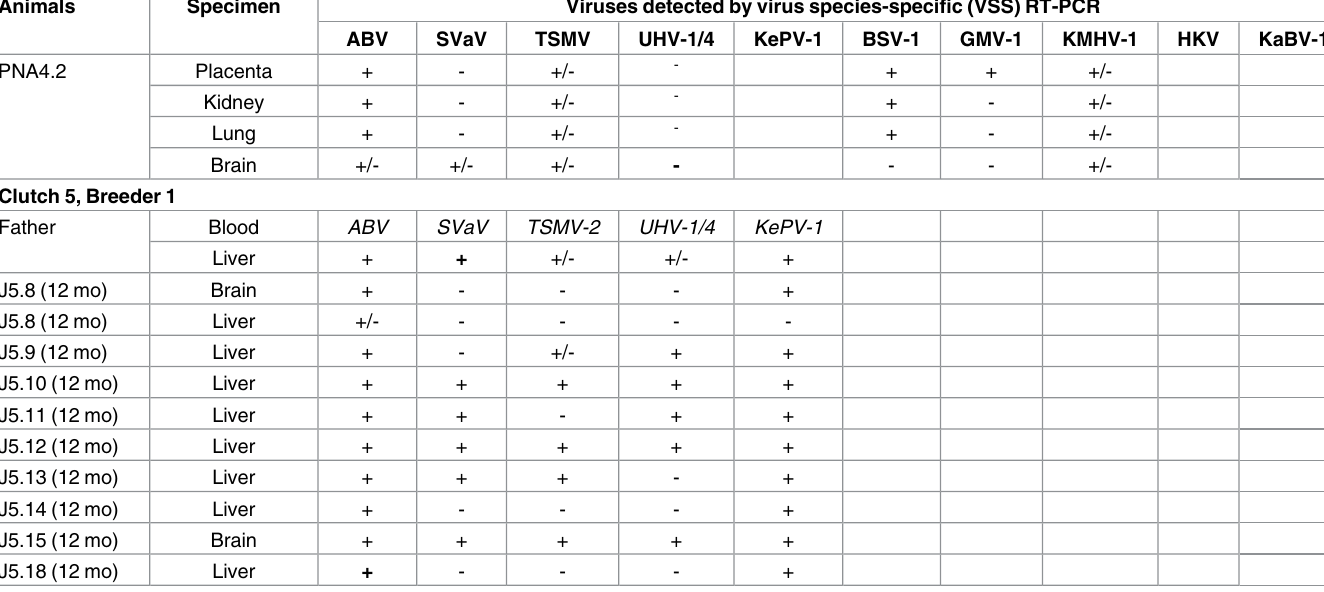
Bold–L segments derived by NGS and de novo assembly; blank box–not tested. tissues which were examined for E1.1 and E1.2. The VSS RT-PCRs confirmed the presence of several to all parental L and S segments in the embryonal tissues (E1.1 and E1.2) and cultured brain cells (E1.6 and E1.7) (Tables 2 and 3). For clutch 2, reads matching two L and both S segments were identified by mapping the NGS data of E2.1 (kidney cell culture), E2.2 and E2.3 (both tissue homogenates) against paren- tal viruses (S1 Table). The VSS RT-PCRs confirmed the NGS findings and identified the parental L and S segments also in homogenates of salpinx and placenta and in cultured cells from umbilicus, placenta and organs (Tables 2 and 3). For clutch 3, we identified reads matching three L and two S segments of the maternal viruses for two perinatal abortions (PNA3.1 and 3.3) and reads matching each two L and S segments for the third (PNA3.2) by the mapping approach. VSS RT-PCRs on samples from several organs (brain, kidney, liver) confirmed the NGS findings. They also identified maternal L and S segments in the liver and kidney of the juvenile snakes euthanized at the age of 2 months (Tables 2 and 3). For clutch 4, the mapping approach yielded a few reads matching both the L and S segment of the virus identified in the father in one perinatal abortion (PNA4.1), and for the second (PNA4.2), only a single read matching the L segment. Since the subsequent VSS RT-PCR of the PNA samples yielded only a weak reaction for the TSMV-2 L segment, we then applied all L seg- ment primers available from the different viruses to RNA extracted from paternal blood and lung, and from the maternal blood sample. Curiously, while the brain of the father remained positive for only a single virus, the blood contained a further 7 reptarenavirus L segments, three of which were also found in the maternal blood. VSS RT-PCRs then identified several paternal L and S segments in the tissues of both perinatal abortions (Tables 2 and 3). Since the results obtained from clutches 1, 3 and 4 suggested that we had characterized the “reptarenavirome” of breeder 1’s collection, we did not perform NGS for clutch 5, but tested the father and several of his 12-month-old juvenile offspring, which were in the majority